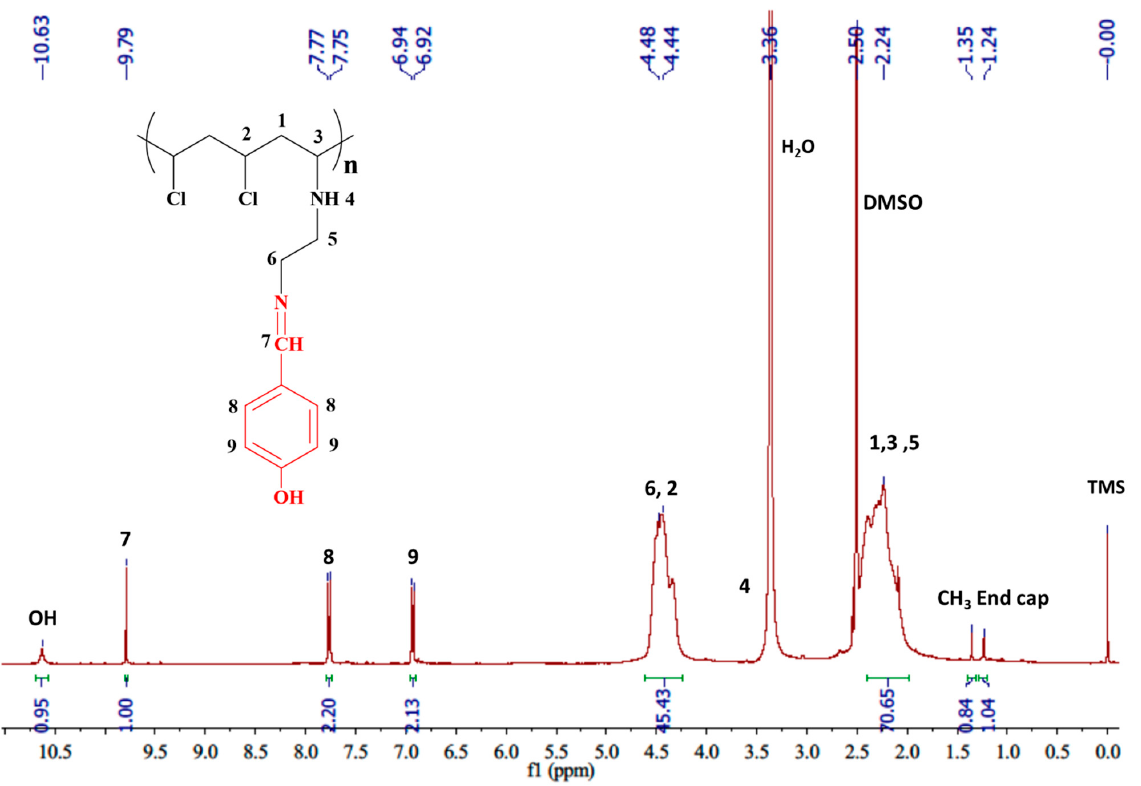
Figure 2. 1 H NMR spectrum of PVC-ed/p-OH.